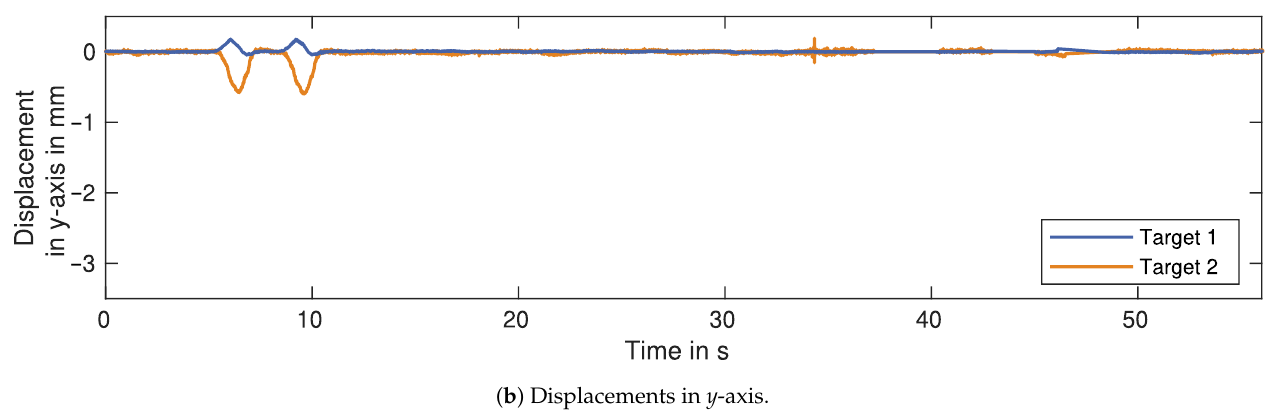
Figure 13. Section of projected displacements for both targets.